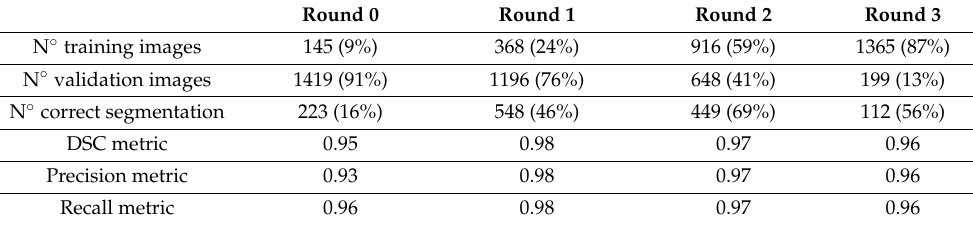
Table 1. Results obtained by the U-Net model using the active semi-supervised learning procedure at each round. We report the number of images used for the training, the number of images used for the validation, the number of correctly segmented validation images (according to the expert evaluation), and the metric scores achieved (on the test set) after 150 epochs for each round of training, respectively. The percentages of training and validation images are referred to the whole set of available samples, i.e., 1564 images. The percentage of correct segmentation is referred to the total number of validated images per each